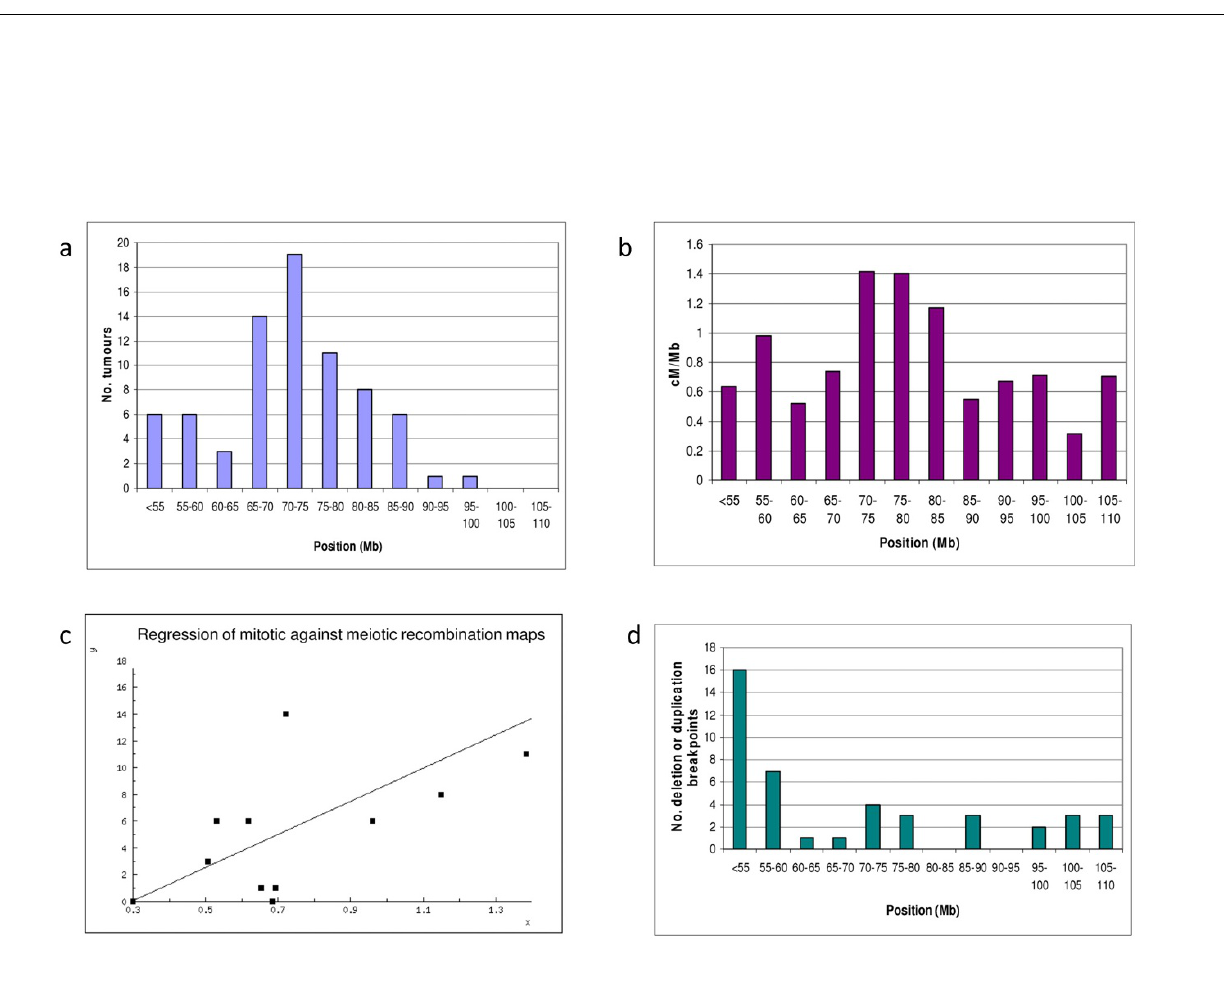
Figure 2 Locations of mitotic recombination breakpoints and comparison with meiotic recombination and deletion breakpoints . (a) Frequencies and positions (in 5 Mb bins along chromosome 5) of mitotic recombination breakpoints in colorectal adenomas are shown. There is evident deviation from the flat distribution expected if cross-overs were random. (b) A plot of meiotic recombination breakpoints, expressed as cM/Mb, is shown, derived from the deCODE genetic map. (c) Lin- ear regression of mitotic recombination frequency (y-axis) against meiotic recombination frequency (x-axis) is shown. (d) Fre- quencies and positions (in 5 Mb bins along chromosome 5) of deletion/duplication breakpoints in colorectal carcinomas are shown; copy number changes on 5q are very rare in adenomas. There is evident deviation from the flat distribution expected, largely as a result of clustering at the